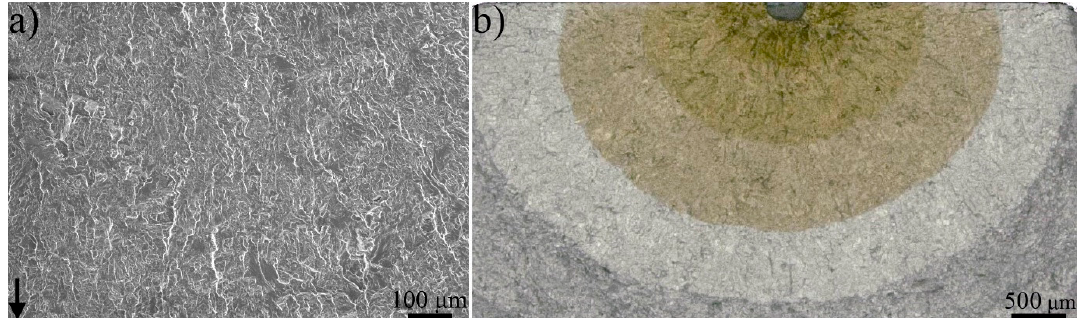
Figure 8. ( a ) 100 × magnification fracture surface image of air-tested material (sample Air-B) in the region ~Y. ( b ) lower magnification image that shows an overview of the whole fracture surface. The black arrow points towards the crack propagation direction.